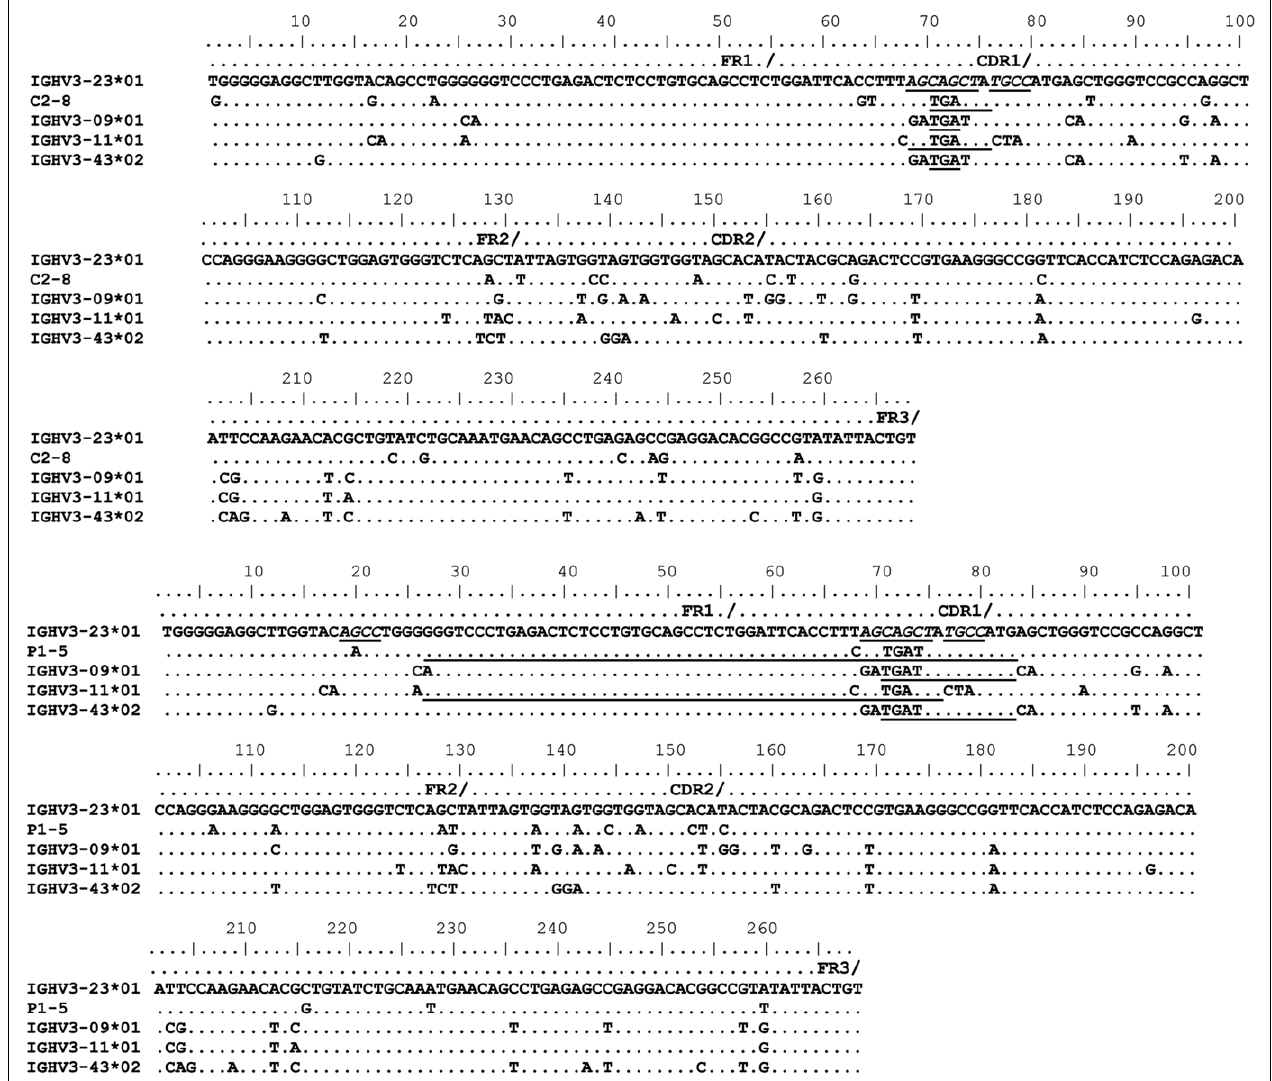
germline of rearranged IGHV3-23*01 gene sequences from a healthy individual (C2–8) and a CVID patient (P1–5). Potential donor germline IGHV3 family gene segments are shown below the rearranged IGHV3-23*01 sequences. GCV-like tract is underlined. Flanking SHM/AID hotspot motifs are underlined and